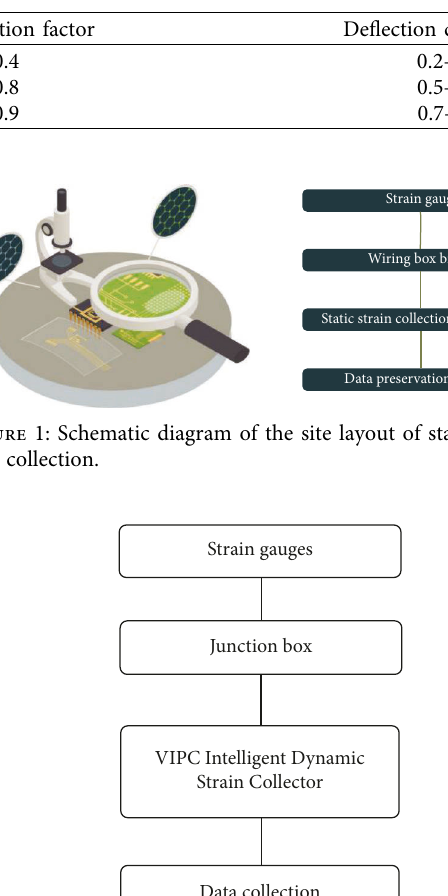
Table 1: Efficiency constant table of the bridge static load test.